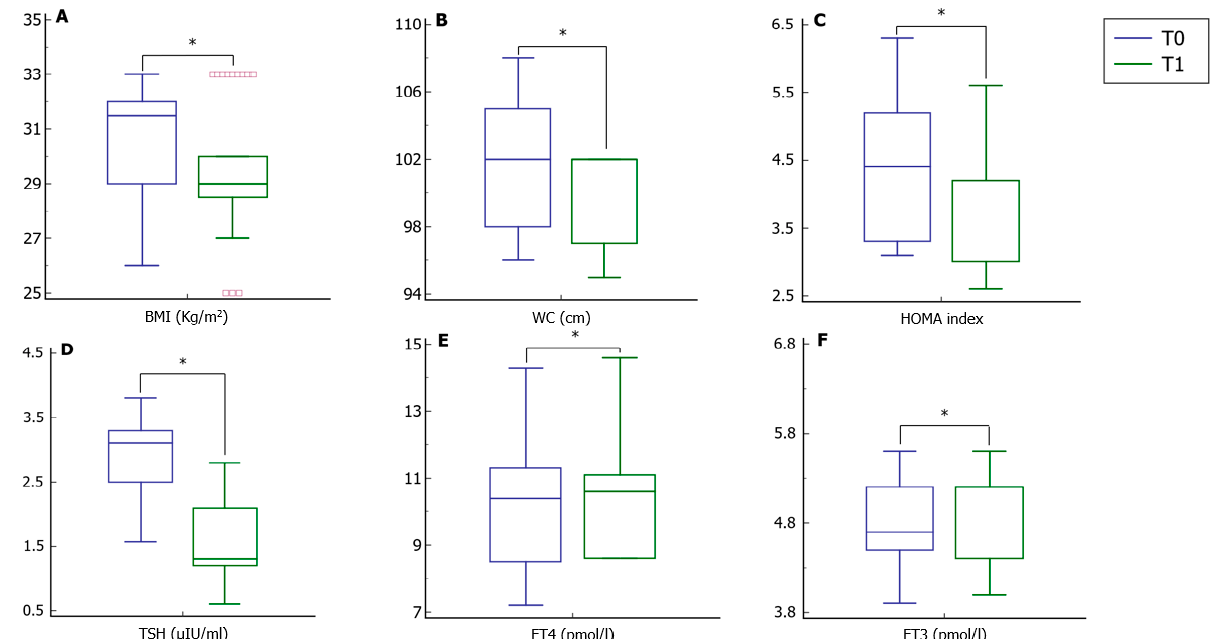
Figure 1. Anthropometric parameters and thyroid function tests before and after treatment with metformin. Panels ( A – C ) show a significant reduction in the body mass index (BMI), waist circumference (WC), and homeostatic model assessment (HOMA) index after treatment with metformin, respectively. Panels ( D – F ) show a significant reduction in the thyroid-stimulating hormone (TSH) and a significant increase in both free-thyroxine (FT4) and free-triiodothyronine (FT3) serum levels after treatment with metformin, respectively. T0, values at baseline; T1, values after six months. * p < 0.05.